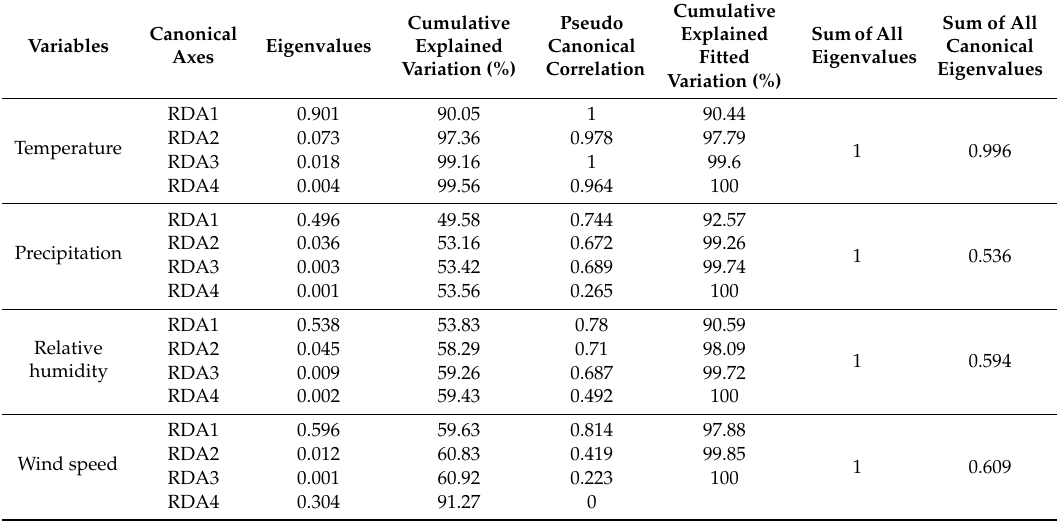
Table 4. The calculation summary of the redundancy